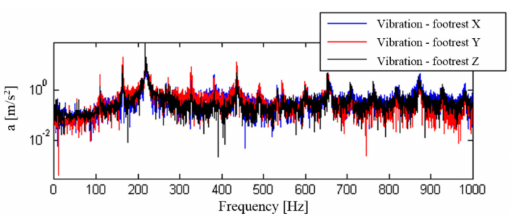
Figure 11. Frequency analysis of general vibration (footrest) in the X, Y and Z directions: ( a ) speed